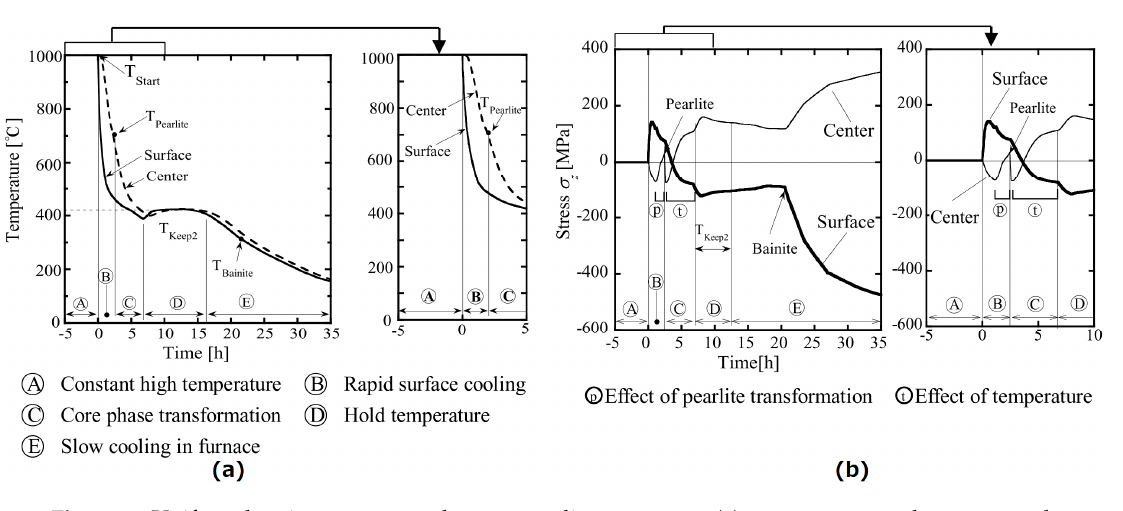
Figure 7. Uniform heating process and corresponding stress, 𝜎 (cid:3053) : ( a ) temperature at the center and surface; ( b ) stress, 𝜎 (cid:3053) , at the center and surface. surface; ( b ) stress, σ z , at the center and surface.